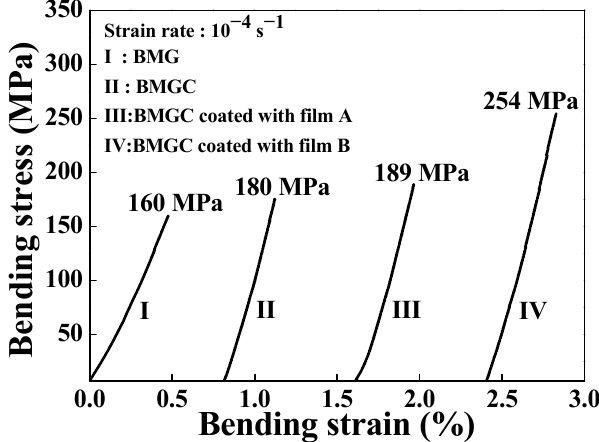
Figure 6. Stress-strain curves of bending tests for the samples of Mg-based BMG, Mg-based BMGC, and Mg-based BMGC with Zr-based MGTF coating.